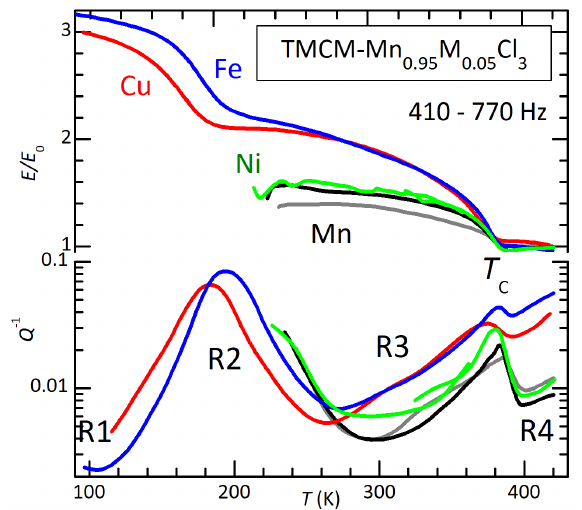
Figure 6. Normalised Young’s modulus E / E 0 = ( f / f 0 ) 2 and elastic energy loss coefficient Q − 1 of TMCM-Mn 0.95 M 0.05 Cl 3 (M = Mn, Ni, Cu, Fe) measured during cooling exciting the 1st flexural modes, whose frequencies at high temperature are indicated. The labels R n indicate the thermally activated relaxations that were observed also in the dielectric spectra.